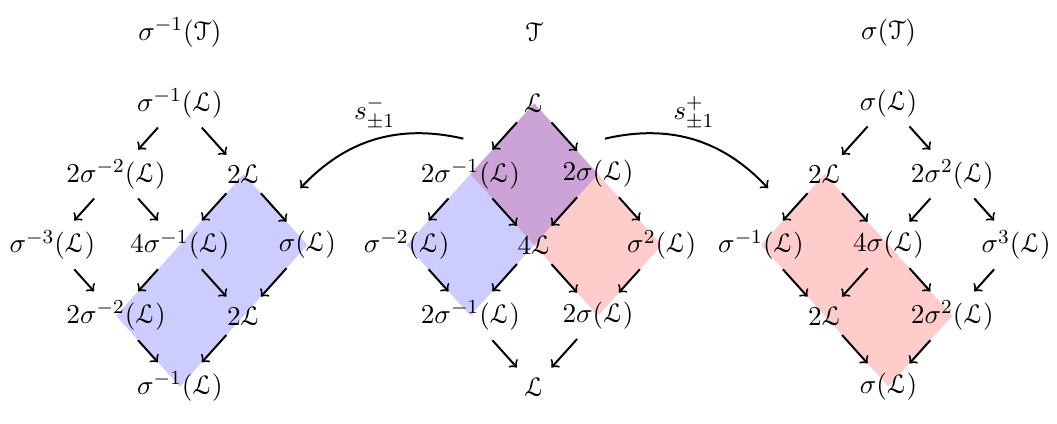
Figure 1 . The de(cid:12)nition of the maps s (cid:6)